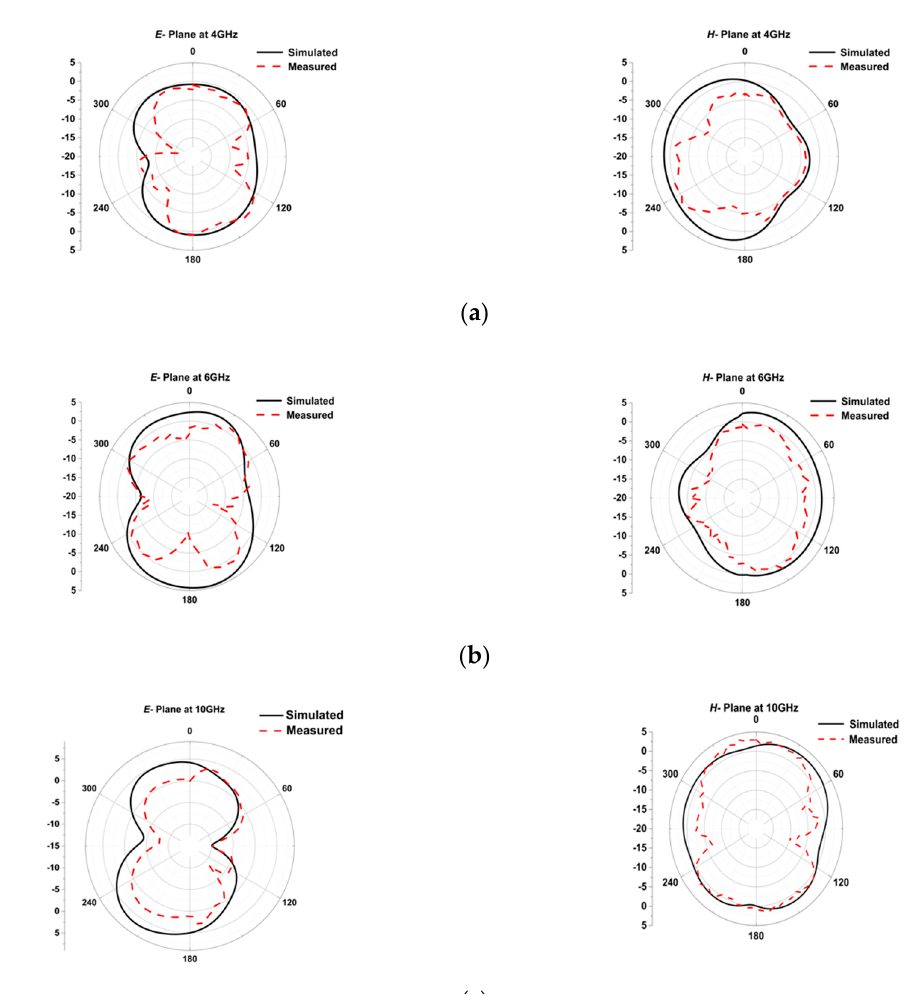
Figure 10. E and H plane radiation patterns: ( a ) 4 GHz; ( b ) 6 GHz; ( c ) 10 GHz.